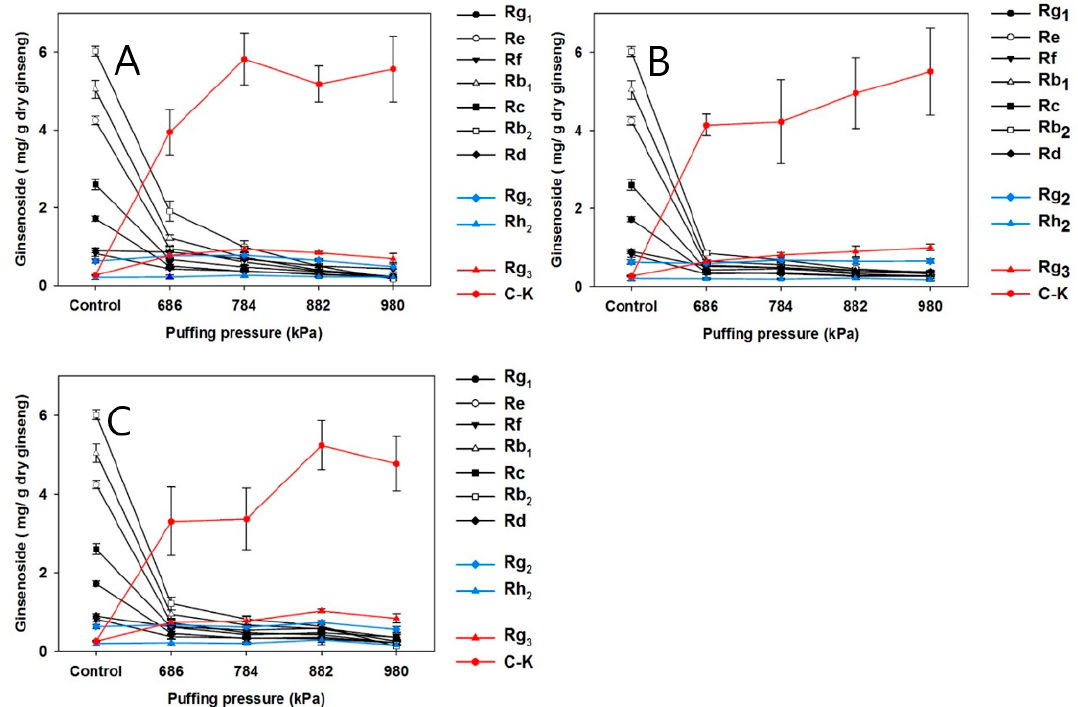
Figure 2. Changes in ginsenoside contents of puffed CWPG with different puffing pressure and moisture contents: ( A ) 8% moisture content, ( B ) 10% moisture content, ( C ) 14% moisture content.